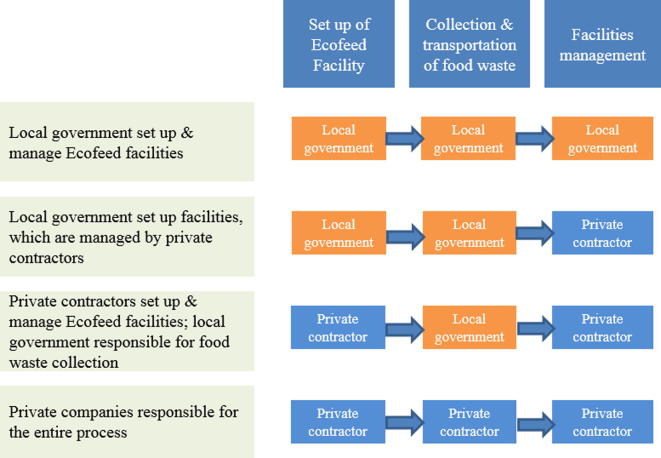
Ecofeed facilities in South Korea are managed through a combination of public and private partnerships.